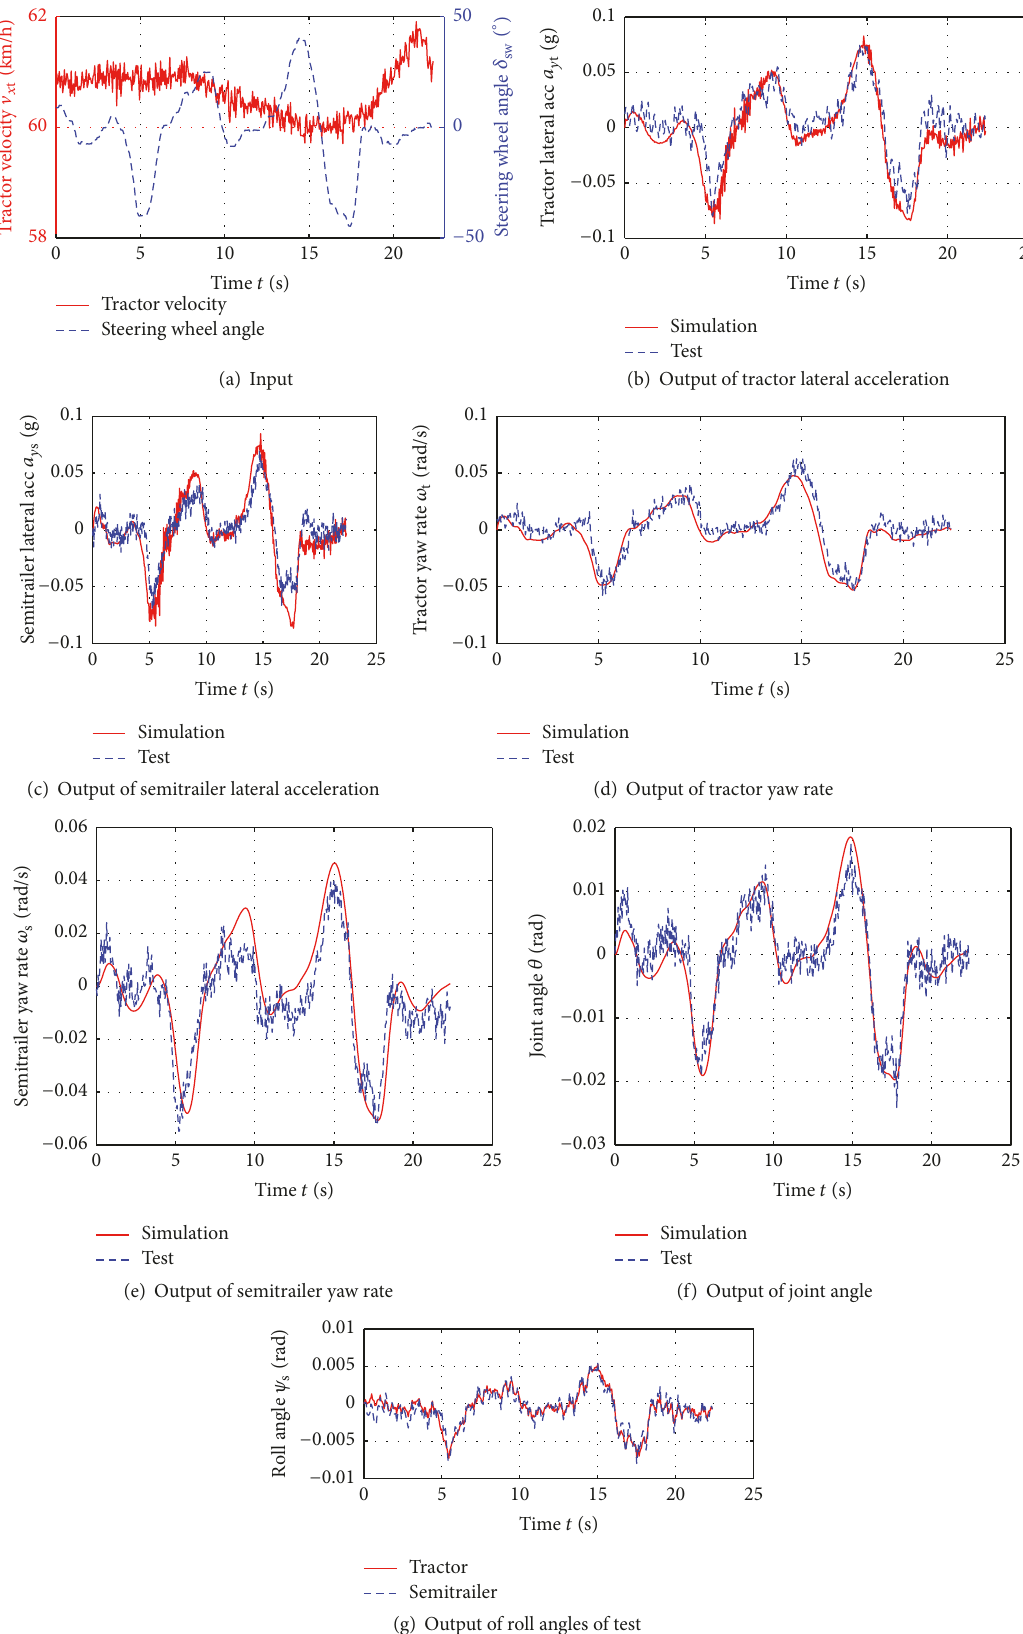
Figure 3: Comparison of simulation and vehicle